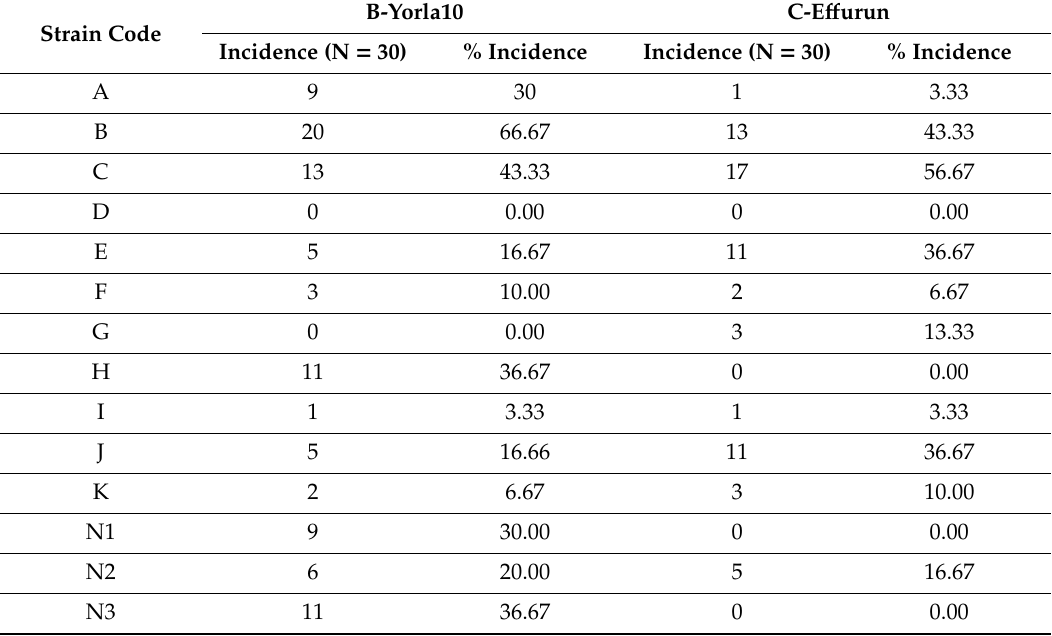
Table 1. Incidence and dominant fungal strains isolated from crude oil polluted